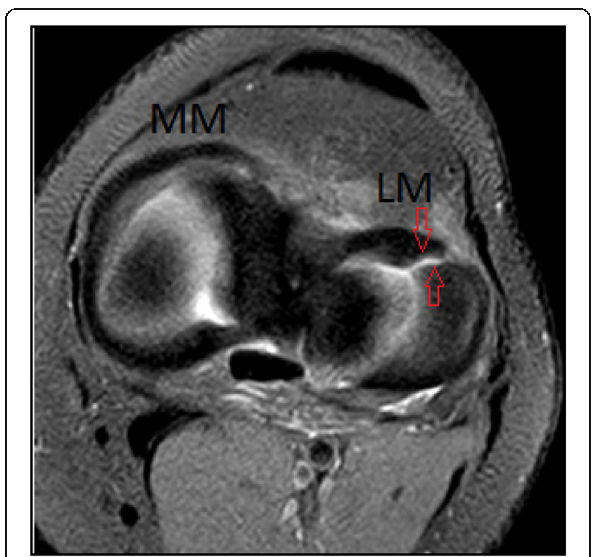
Fig. 3 Axial PD fat-saturated images revealed a complete radial tear of the lateral meniscus (at the junction between the anterior horn and body, red arrows), extending from the free meniscal edge to the capsular surface. LM = lateral meniscus and MM = medial meniscus